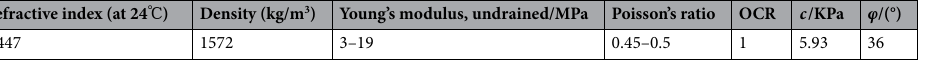
Table 1. Properties of transparent